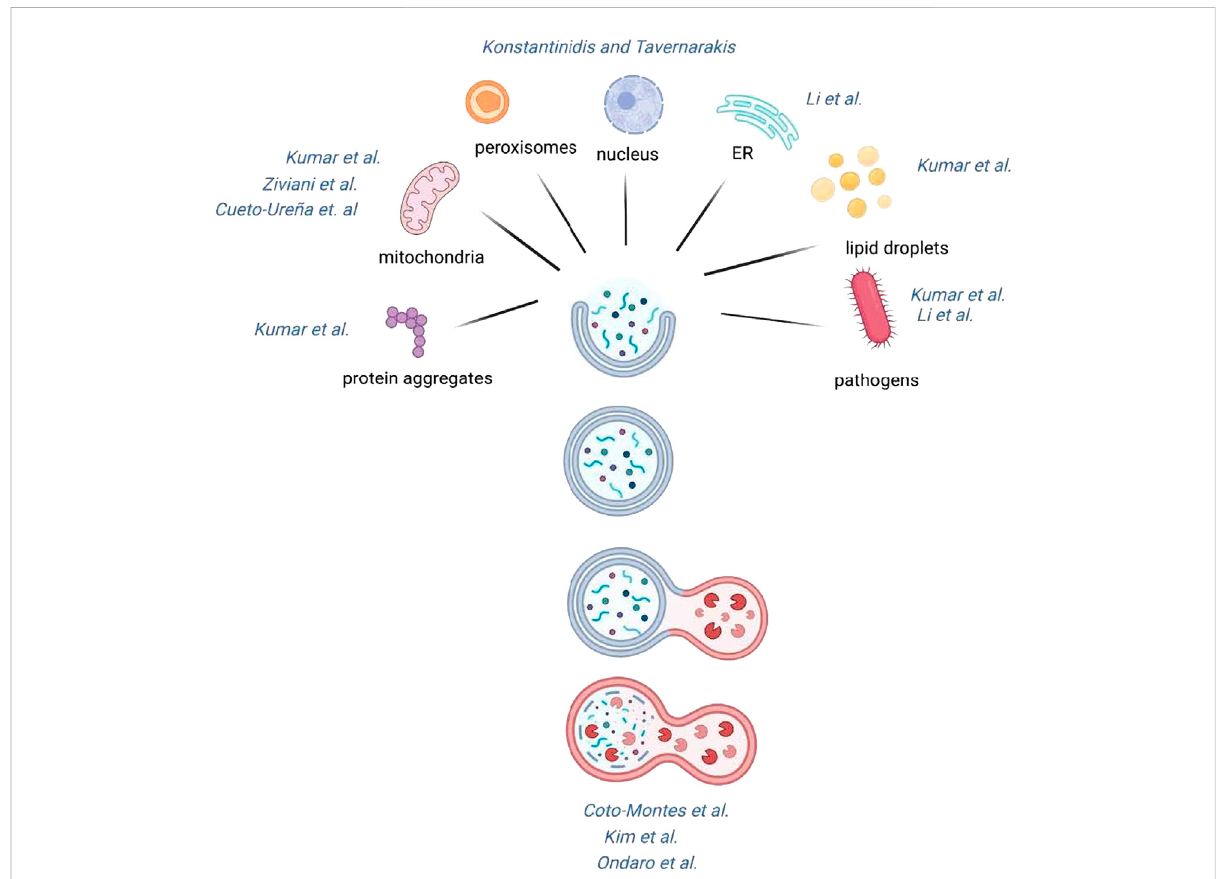
FIGURE 1 Schematic representation of selective macroautophagy. Speci fi c cargos, such as dysfunctional organelles or invading microbe, are initially sequestered by the phagophore and engulfed in the forming double-membrane autophagosome. The autophagosome ’ s outer membrane subsequently fuses with the lysosome releasing the enclosed material in the autolysosome, where the sequestered cargos are degraded by